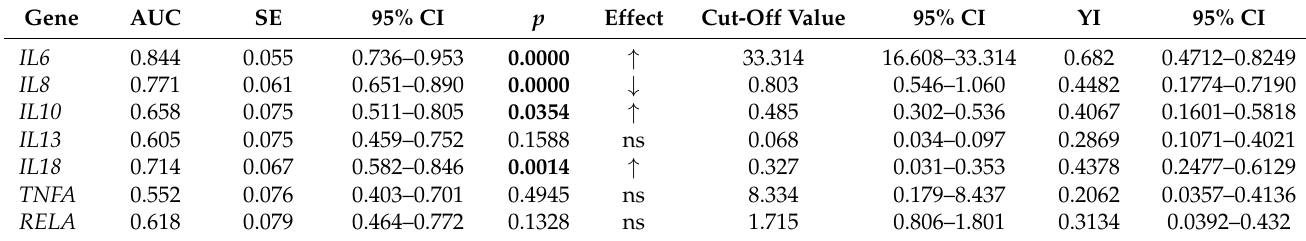
Table 5. The validity of gene expression in discriminating pregnant GDM and NGT women at GDM diagnosis ( n =